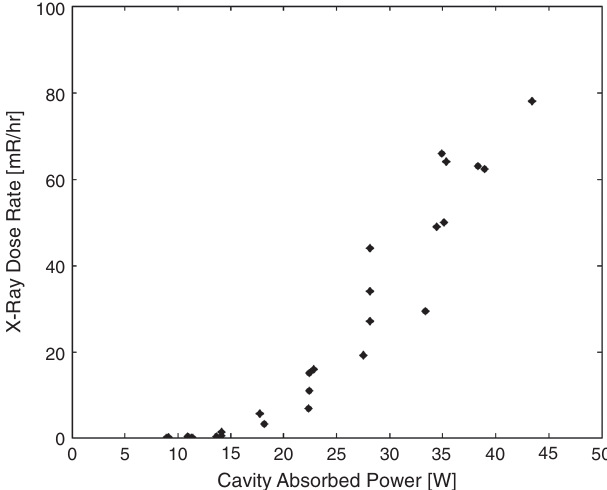
FIG. 21. Radiation dose rate as a function of rf power absorbed in the